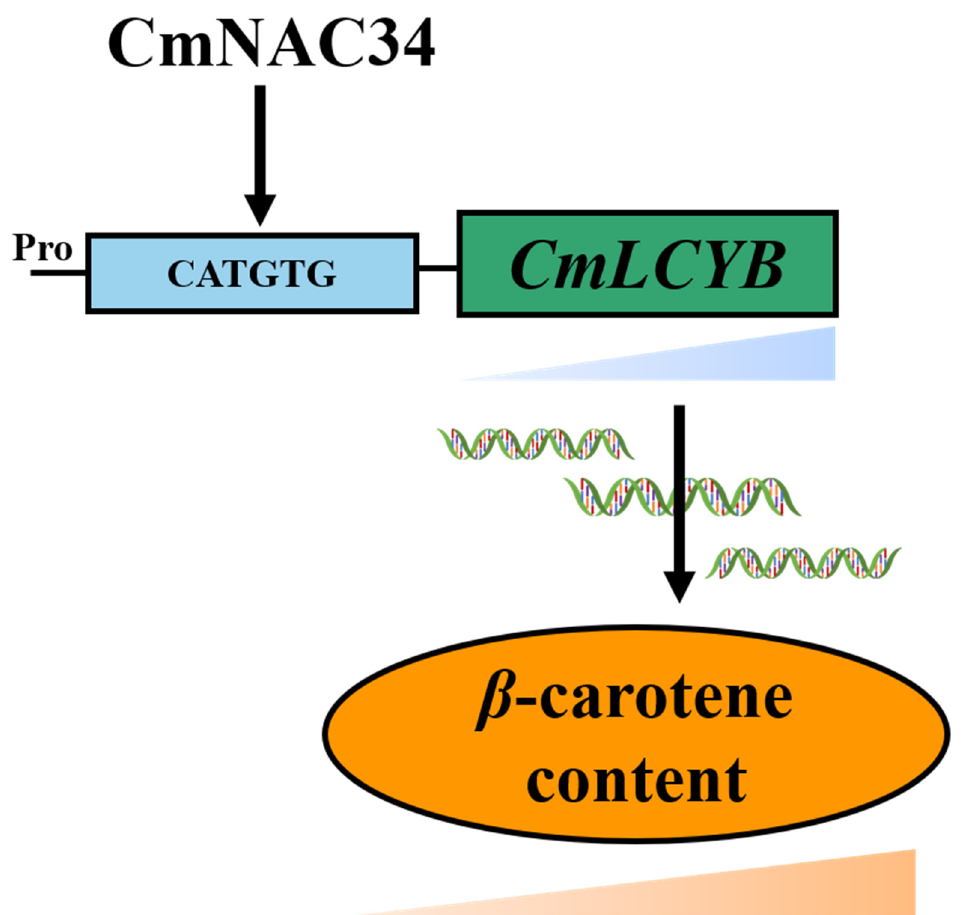
Figure 6. Proposed model of CmNAC34 function in CmLCYB regulating β -carotene accumulation during the oriental melon fruit ripening. The CmNAC34 was involved in carotenoid metabolism by directly binding to the promoter of CmLCYB and activating its transcription.